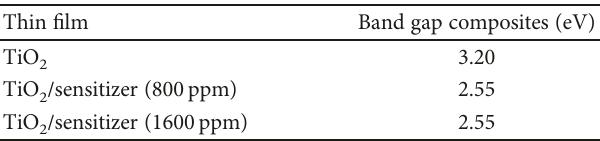
Figure 3: Di ff use re fl ectance spectrum of TiO /sensitizer using two loads of cyanobacterial biomass; inset: it is showing the analog to Tauc 2 plots for re fl ectance spectra. Table 3: The energy band gap values for thin fi